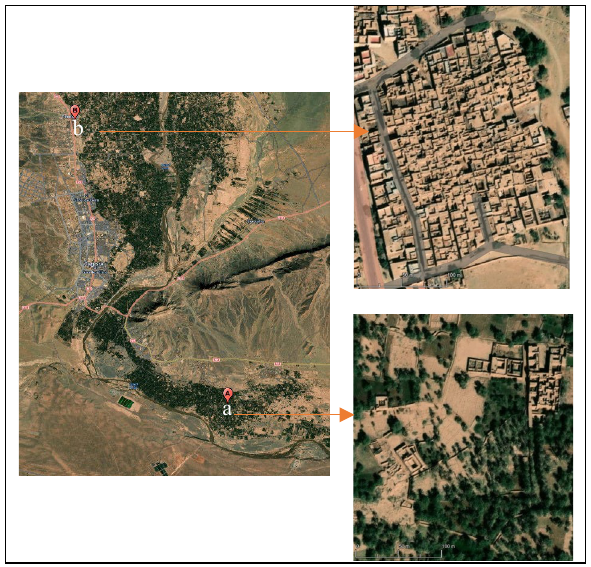
Figure 2 . Satellite image of the study area in 2020 and example of (a) low-density rural settlement and (b) high-density settlement Figure 4 . Illustration of U-net architecture for semantic segmentation (modified from Ronneberger et